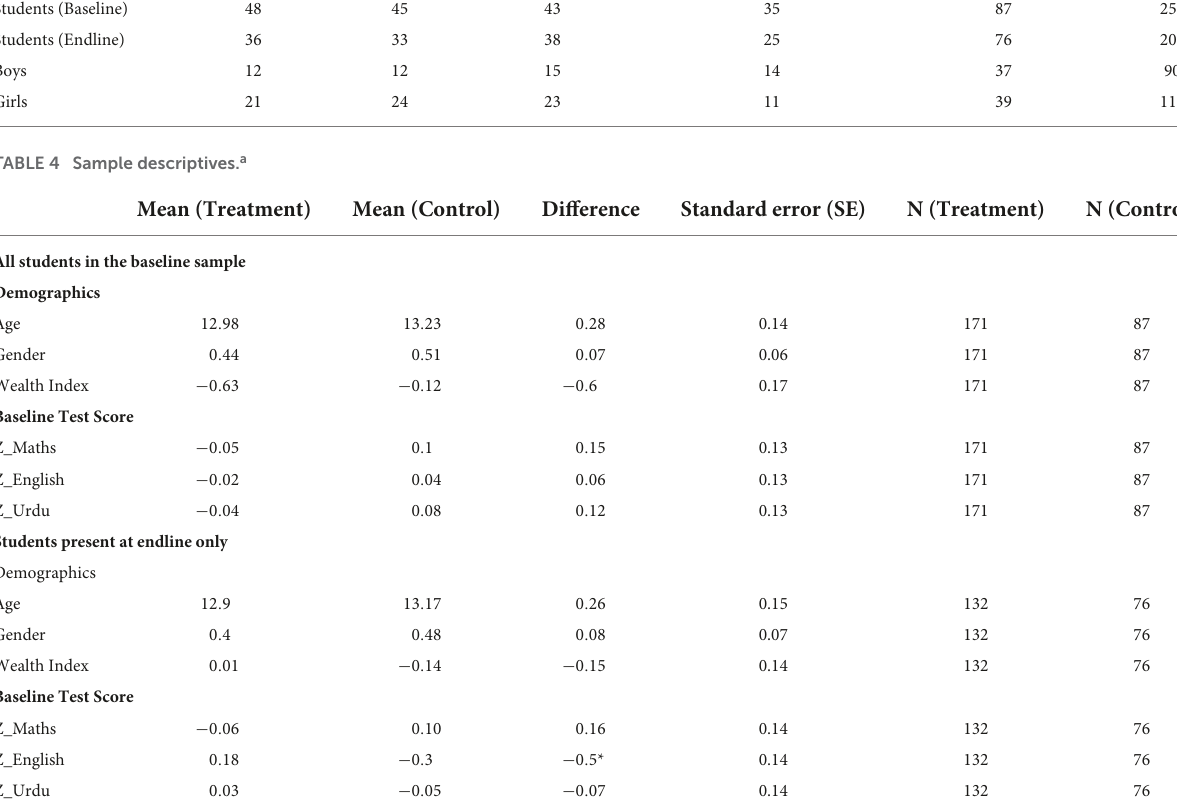
TABLE 3 Distribution of treatment groups in the set of 12 schools at baseline and endline.